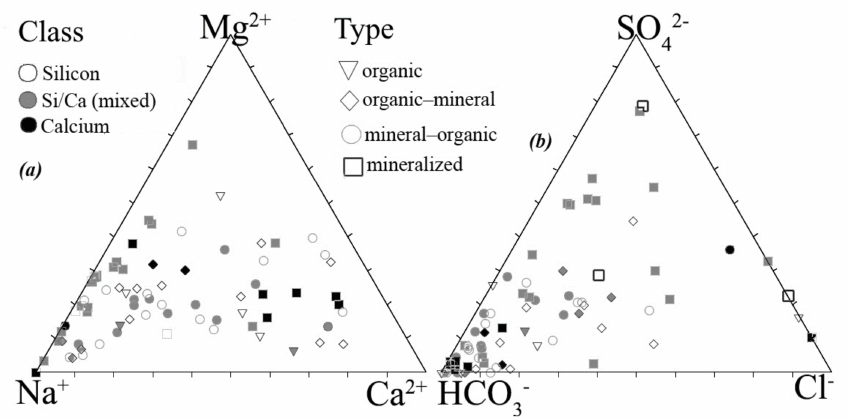
Figure 2. Ferre Triangle of lake water composition, taking into account the type (an ash content) of sapropel deposits formed in the lake and taking into account the chemical composition (according to the Si/Ca ratio) class of the sapropel deposits. ( a ) anionic composition of water, ( b ) cationic composition of water (according to our